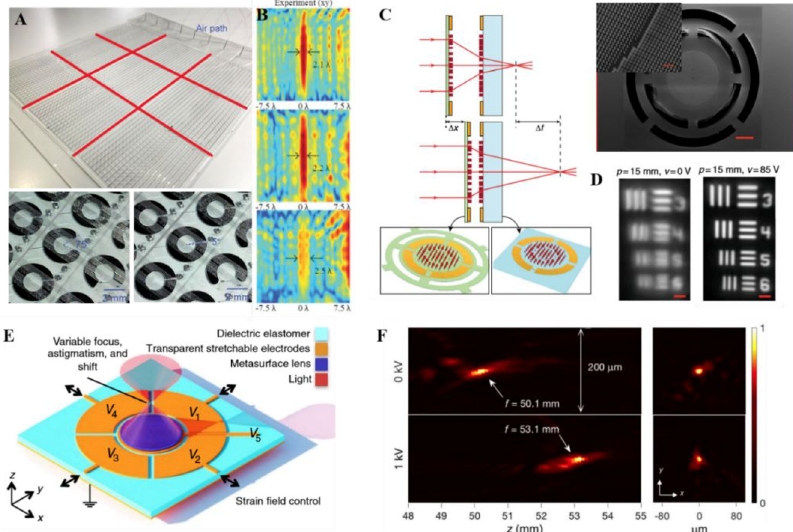
unit cell consists of two metal gratings and an SRR, which is fi lled by the liquid metal mercury through micro fl uidic channels. Two metal gratings enhance the cross-polarization transmission due to the Fabry – Pérot resonance. A small part of the mercury is replaced by the air bubble. By changing the airandmercurypressurewithpneumaticvalves,theopening of the air bubbles can be varied row by row from 0 ° to 150 ° and 2 π phase difference along the x -direction iscreated[107].